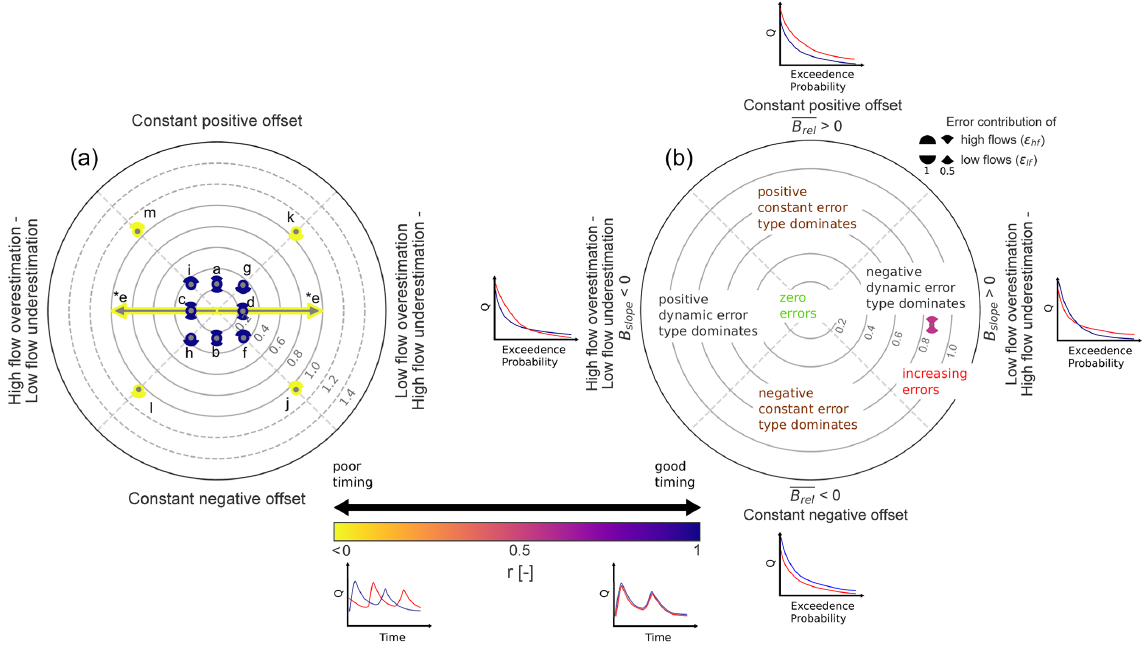
Figure 3. (a) Diagnostic polar plot for manipulated time series generated characterized by constant errors, dynamic errors, and timing errors (a–m) visualizing the overall model performance (DE; contour lines) and contribution of constant error, dynamic error, and timing error – purple (yellow) indicates temporal match (mismatch). The error contribution of high flows and low flows is displayed by pies. ( e ∗ ) Timing error only: type of dynamic error cannot be distinguished. (b) Annotated diagnostic polar plot illustrating the interpretation (similar to Zipper et al., 2018). Hypothetic FDC plots and hydrograph plots give examples of the error types. Table 2. Comparison of DE, KGE and NSE calculated for manipulated time series characterized by constant errors, dynamic errors and timing errors (a–m). Lowest model performance for each error case is in